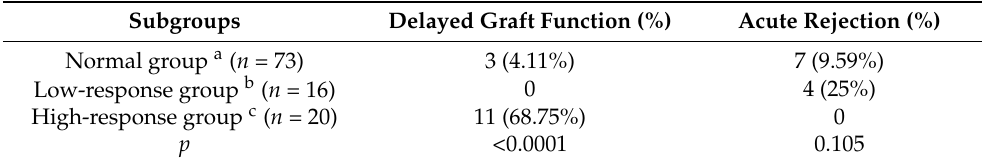
Table 2. The incidence of delayed graft function and acute rejection in different pharmacody- namic subgroups.